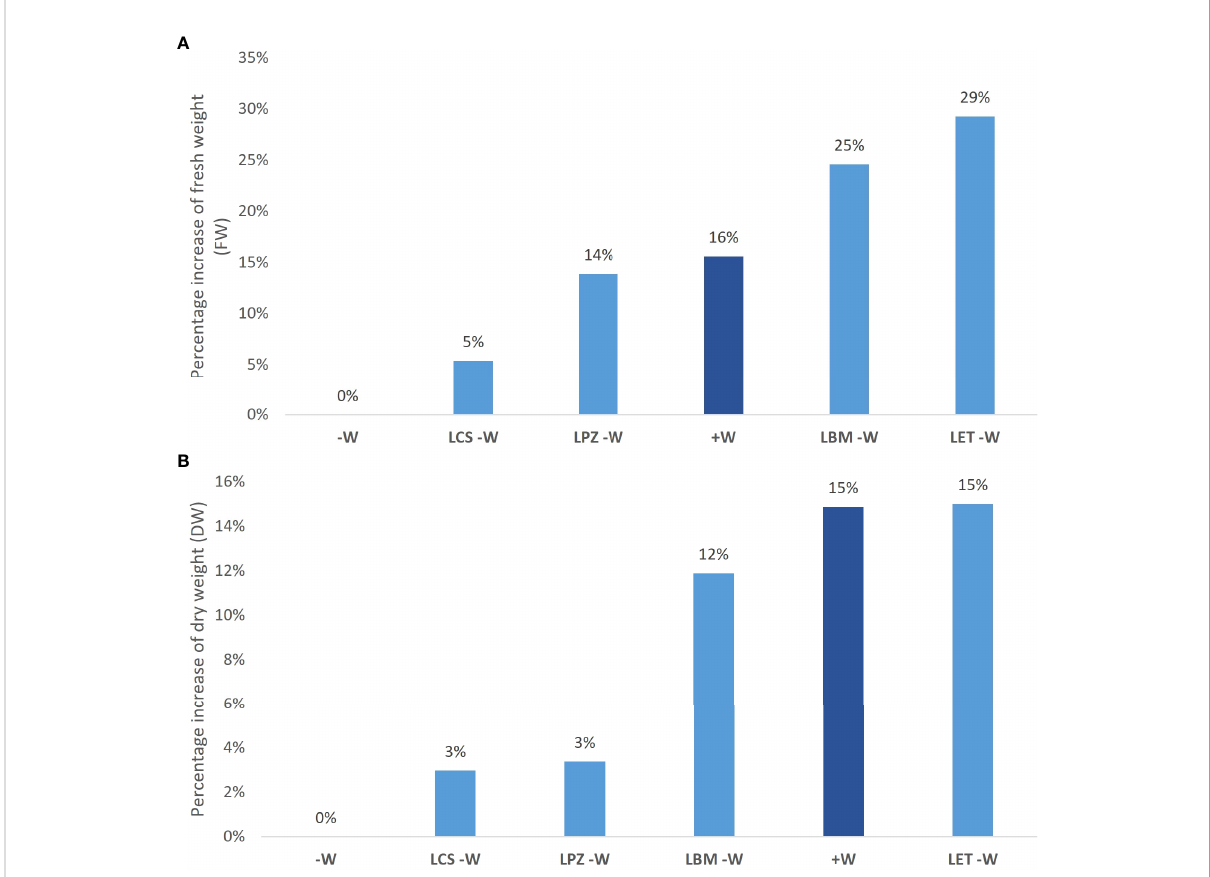
FIGURE 2 Effect of rhizobia strain inoculations on wheat plants under water-stress conditions. Percentage increase in aerial fresh weight (FW) (A) and aerial dry weight (B) of wheat plants inoculated with rhizobia strains LBM, LCS, LET, and LPZ under water-stress conditions and non-water stressed/ non-inoculated plants (+W) compared to water-stress/non-inoculated wheat plants